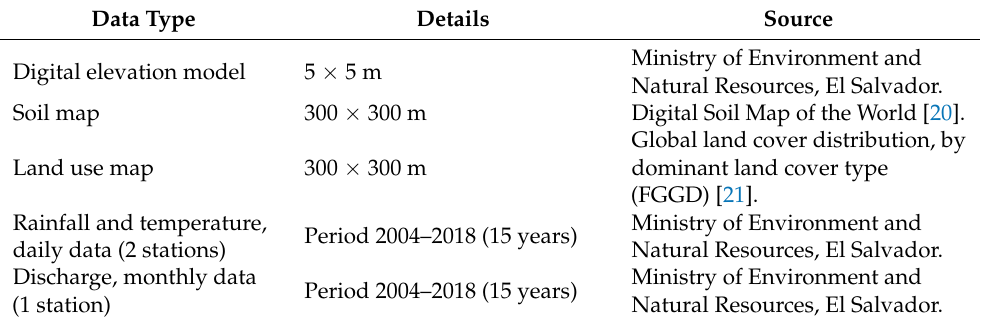
Table 1. SWAT model input